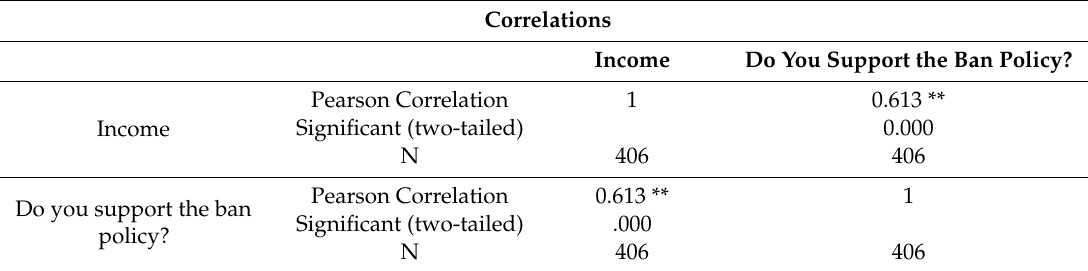
Table A7. Income correlations